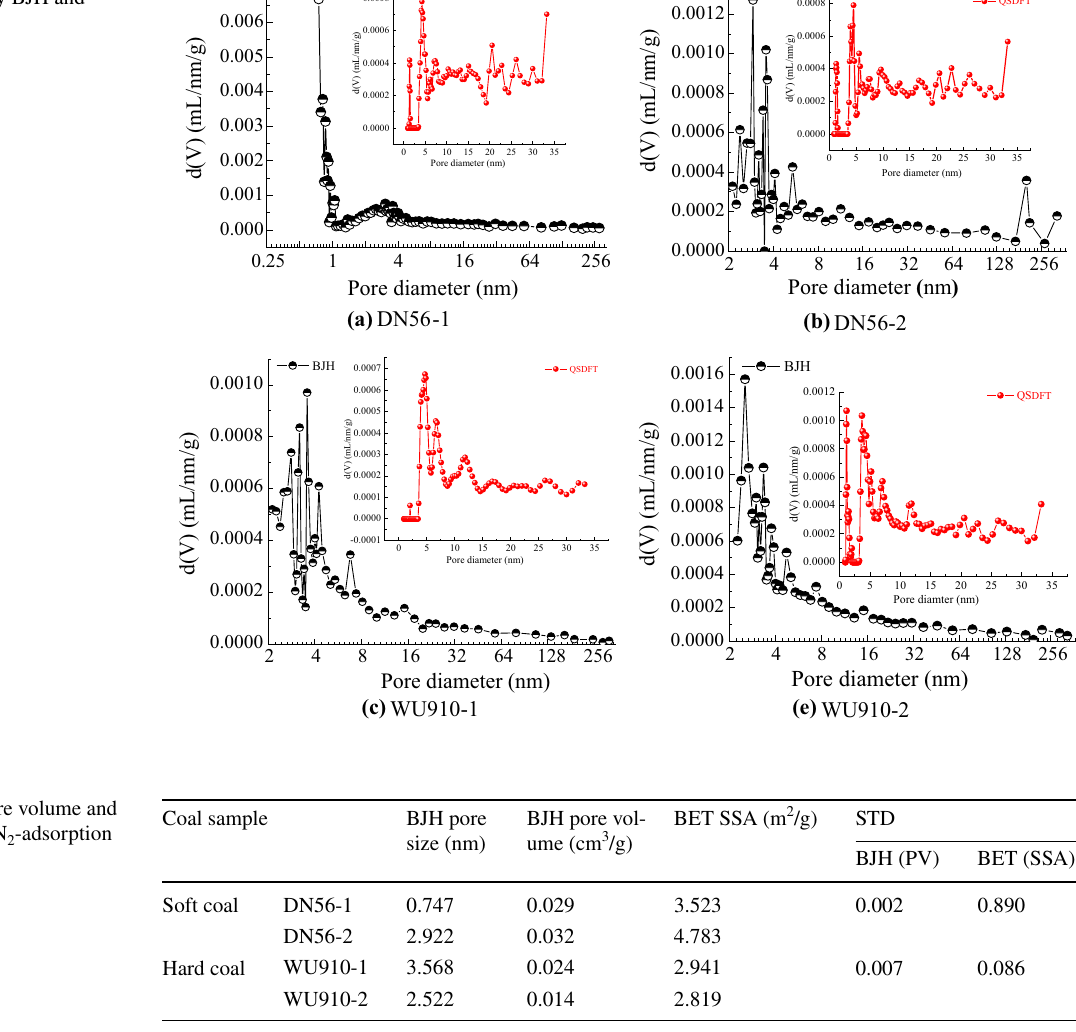
Fig. 3 Pore size distribution of coal determined by BJH and DFT Model